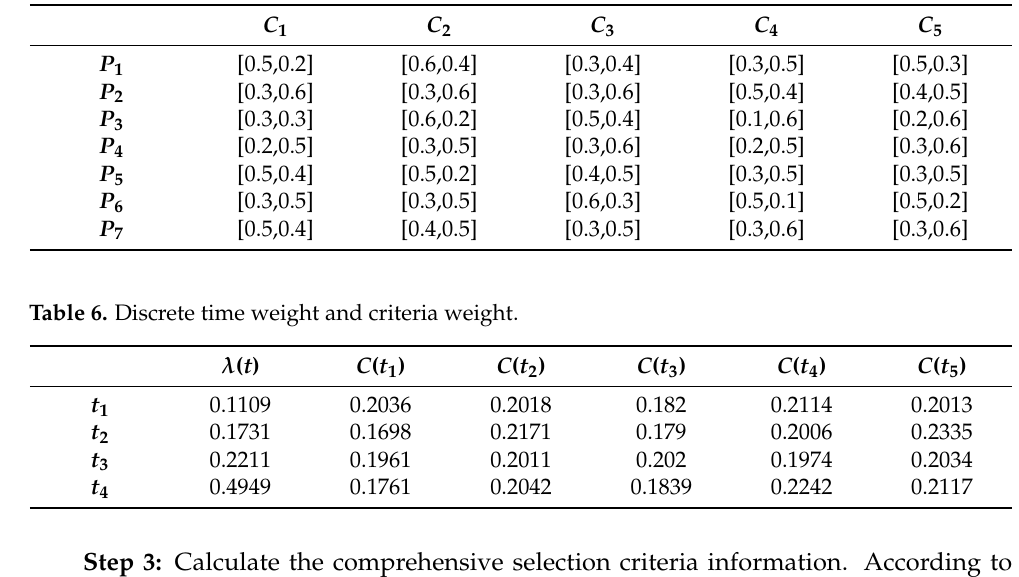
Table 5. Original evaluation criteria information matrix at the moment t 4 .